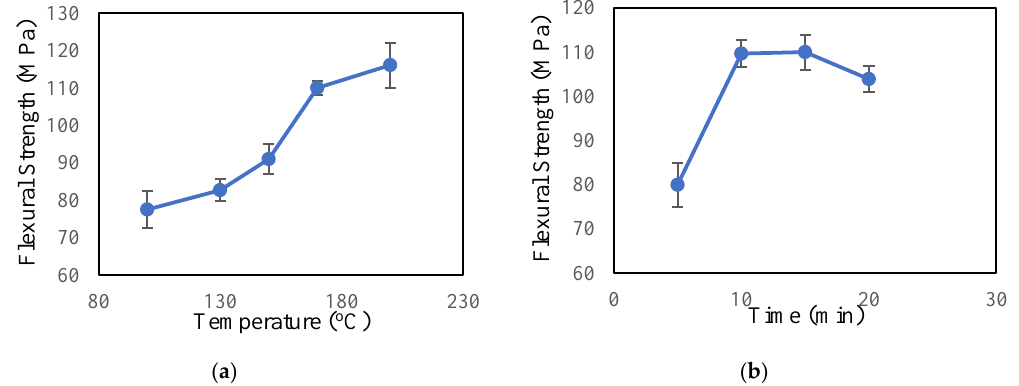
Figure 7. Flexural strength of control sample prepared at different curing conditions. ( a ) At constant time (15 min). ( b ) At constant temperature (170 °C).